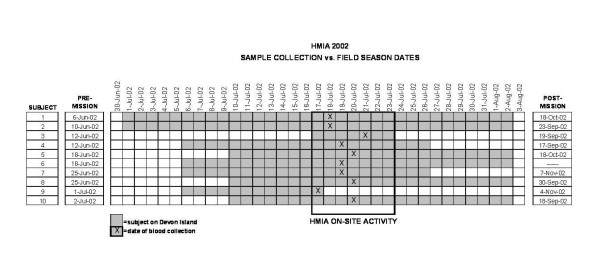
Sample collection dates vs. field season activity for all ten study subjects. Participants are on-location at Devon Island for varying lengths of time, depending on the individual subject's mission objectives. In general, the field season lasts for approximately one month each summer. Sample consisted of 20 ml whole blood. Pre- and post-mission samples were collected at local clinics and overnight shipped to JSC for analysis. Field samples were processed on-location (including cell culture) and stabilized for transport to JSC.